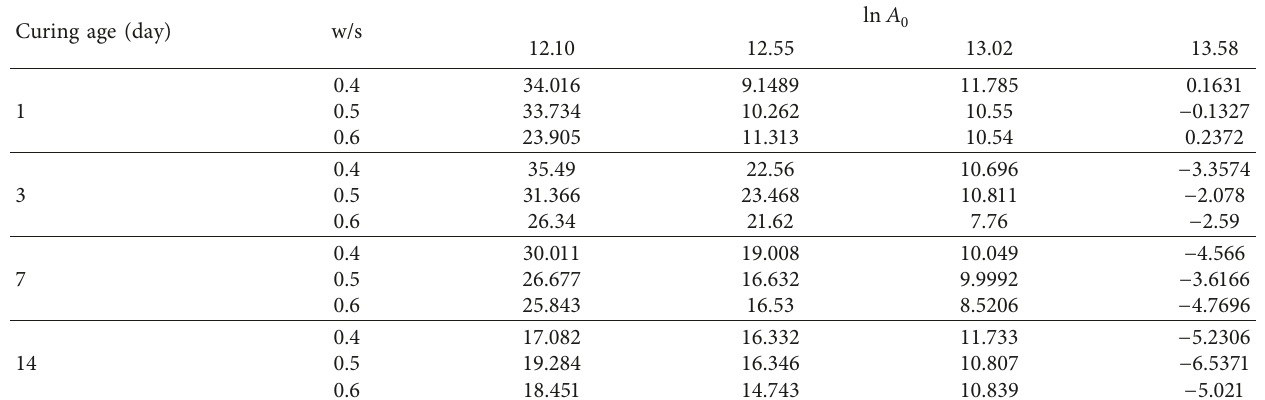
Figure 7: E changes with pH at (a) 1day, (b) 3days, (c) 7 days, and (d) 14days. a Table 3: ln A at different pH 0